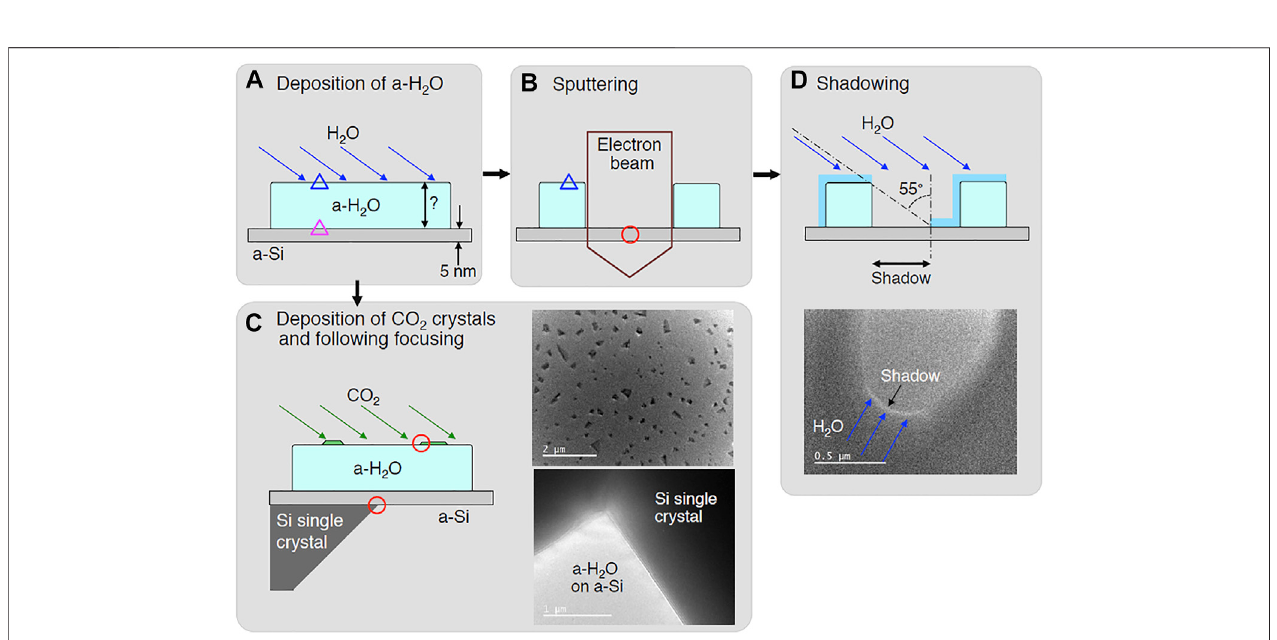
Frontiers in Chemistry |